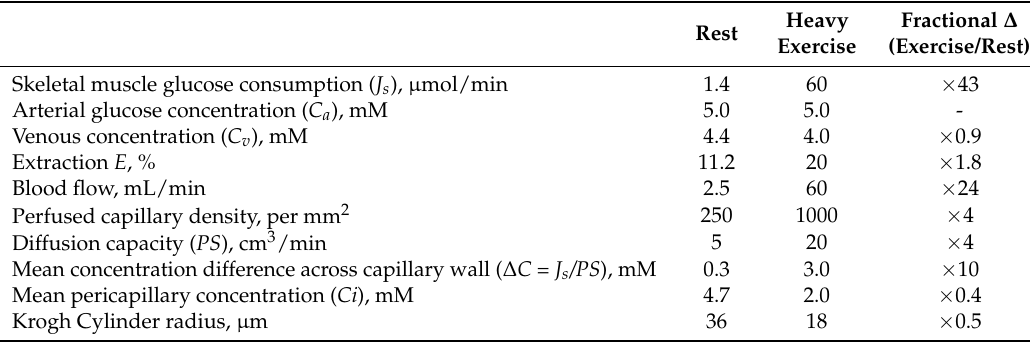
Table 1. Glucose transport from blood to skeletal muscle (per 110/g)